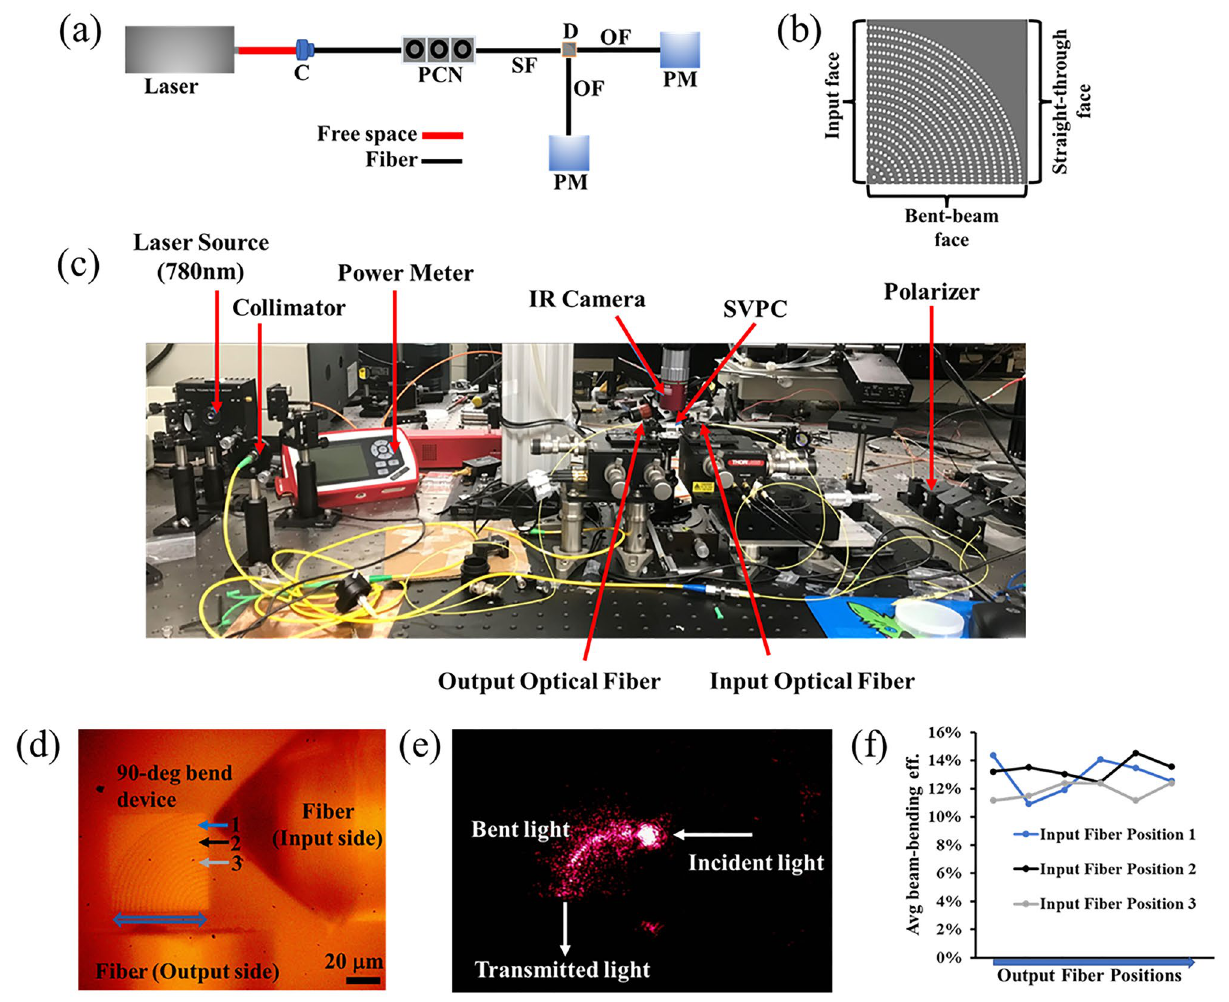
Figure 4. Beam-bending efficiency of the SVPC device. The objects are not drawn to scale. ( a ) Schematic of the experimental setup for characterizing the SVPC device (C: collimator; PCN: polarization controller; SF: source fiber; OF: output fiber; D: SVPC device; and PM: power meter). ( b ) SVPC face identification. ( c ) Experimental setup for prototype SVPC devices. ( d ) Microscope image of the prototype SVPC with the optical fibers for measuring 90-degree beam-bending efficiency. ( e ) Self-collimation and bending of light through the prototype 90-degree bend SVPC. ( f ) Plot of the average beam-bending efficiency; the output fiber is moved from the left to right end on the bent-beam face for measuring the output optical power for each input fiber